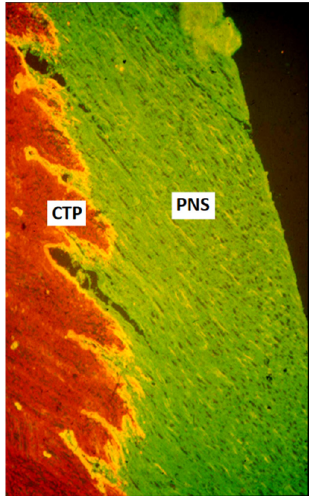
Figure 1. Intact, the lumbar dorsal root of the adult rat. Horizontal section through several dorsal rootlets, immunostained with antibodies to laminin (green) and glial fibrillary acidic protein (GFAP; red). The dorsal root transitional zone is formed by cone-shaped peripheral projections of central nervous tissue, so-called central tissue projections (CTP; red), which interdigitate with the peripheral nervous compartment of the root (green). × 200. Reproduced with permission from Aldskogius, H., Kozlova, E.N., Brain Research Reviews; published by Elsevier, 2002